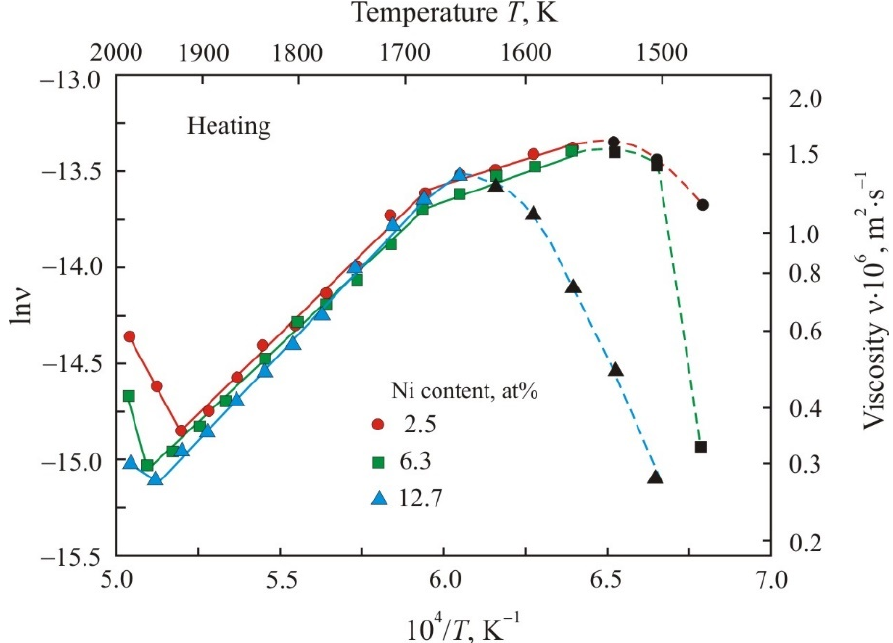
Figure 4. Kinematic viscosity on a natural logarithmic scale ln ν as a function of the inverse absolute